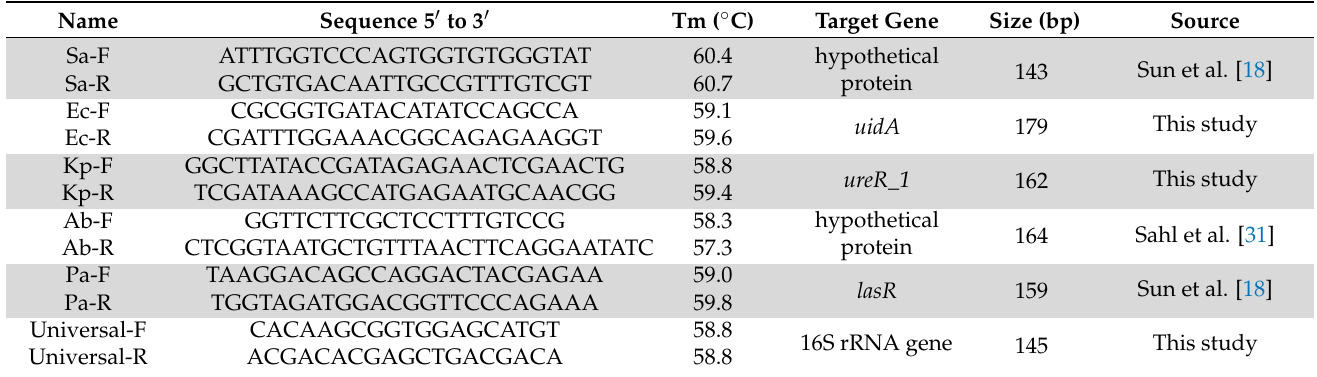
Table 1. Species-specific primer